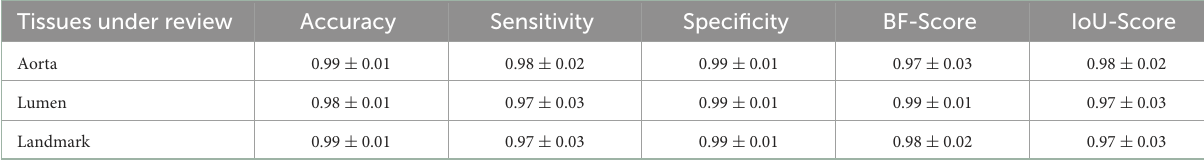
TABLE 1 Measured accuracy, sensitivity, specificity, BF-score, and IoU-score to evaluate the performance of the segmentation model.